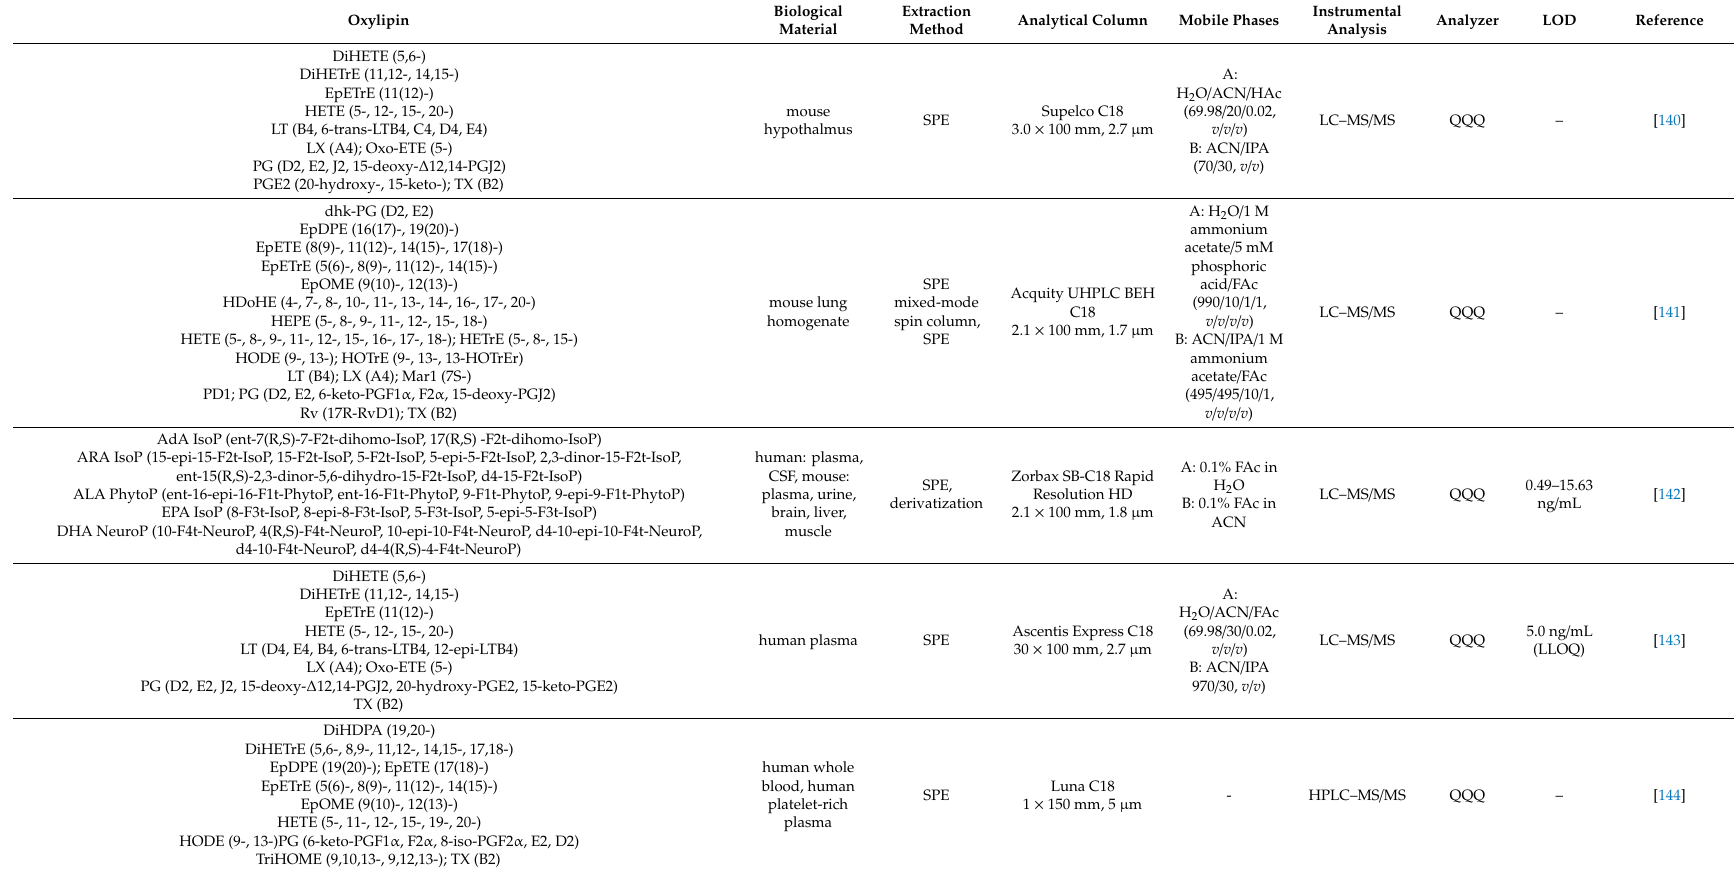
Oxylipin Biological Material Extraction Method Analytical Column Mobile Phases Instrumental Analysis